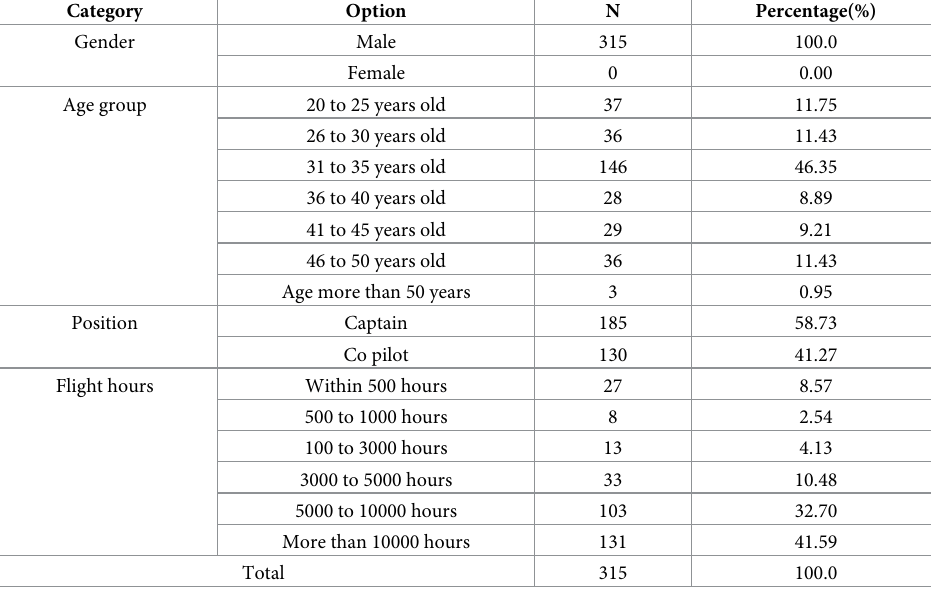
Table 5. Basic information of